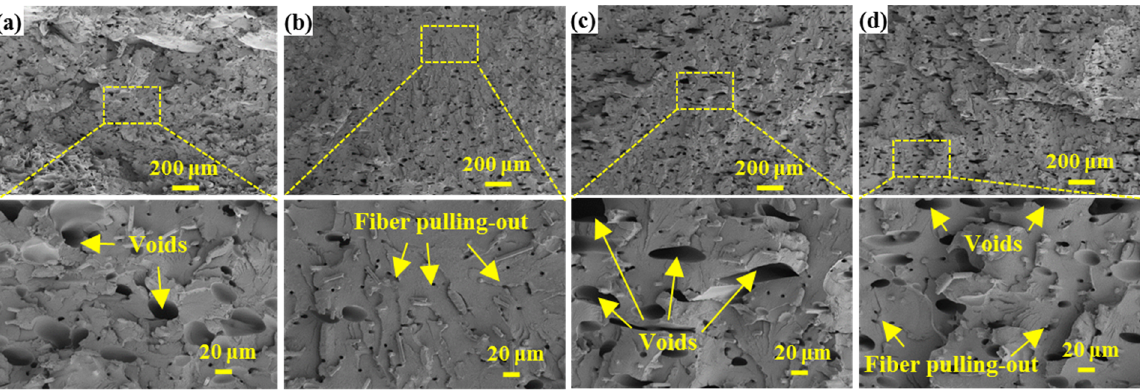
Figure 7. Microstructure of FDM 3D-printed 5 wt% CF/PEEK under different heat treatment processes: ( a ) 150 °C-4 h; ( b ) 300 °C-4 h; ( c ) 250 °C-2 h; ( d ) 250 °C-6 h.